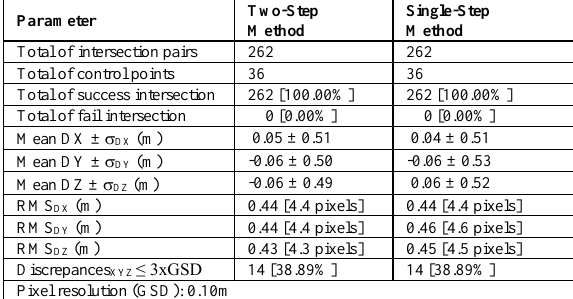
Table 4. Direct georeferencing validation results in an independent image